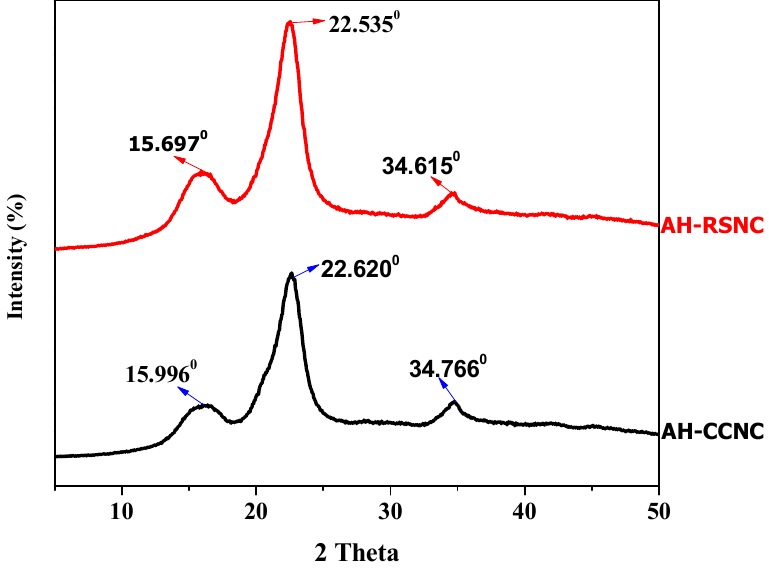
Figure 2. XRD pattern of AH-CCNC and AH-RSNC.